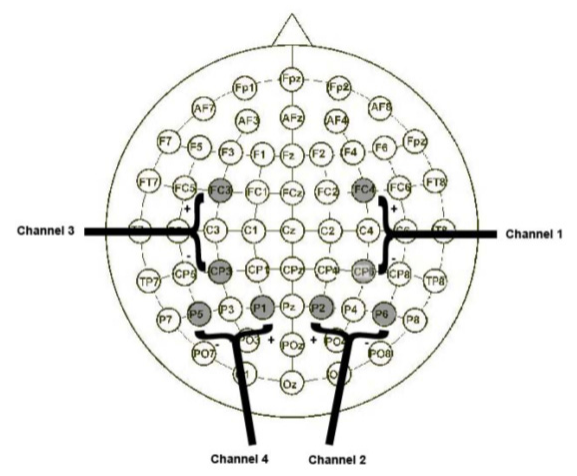
Fig. 4: Position of electrode placements for bipolar EEG recording.